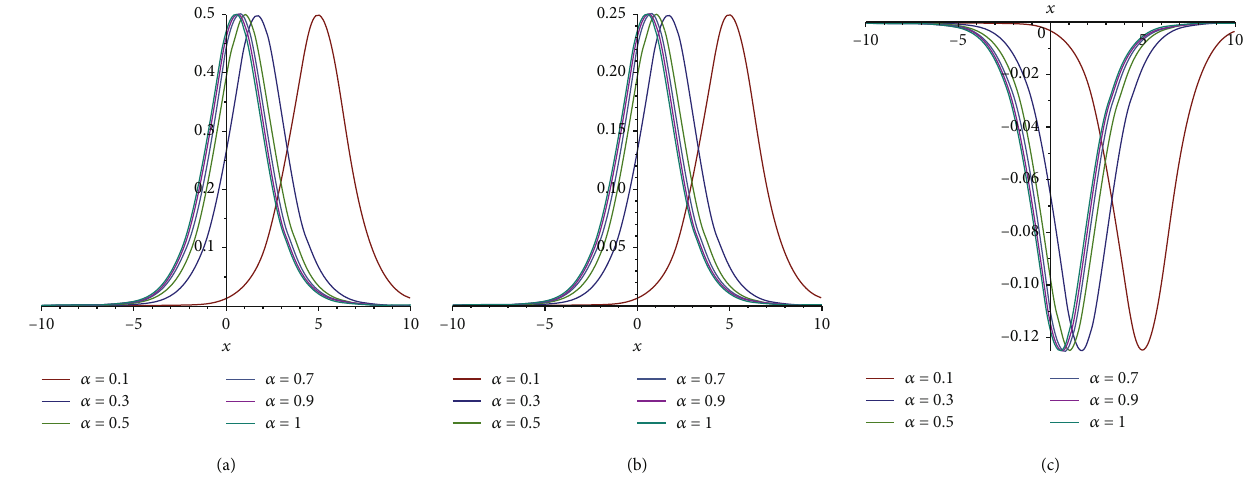
Figure 6: Plots of solution (20) for b